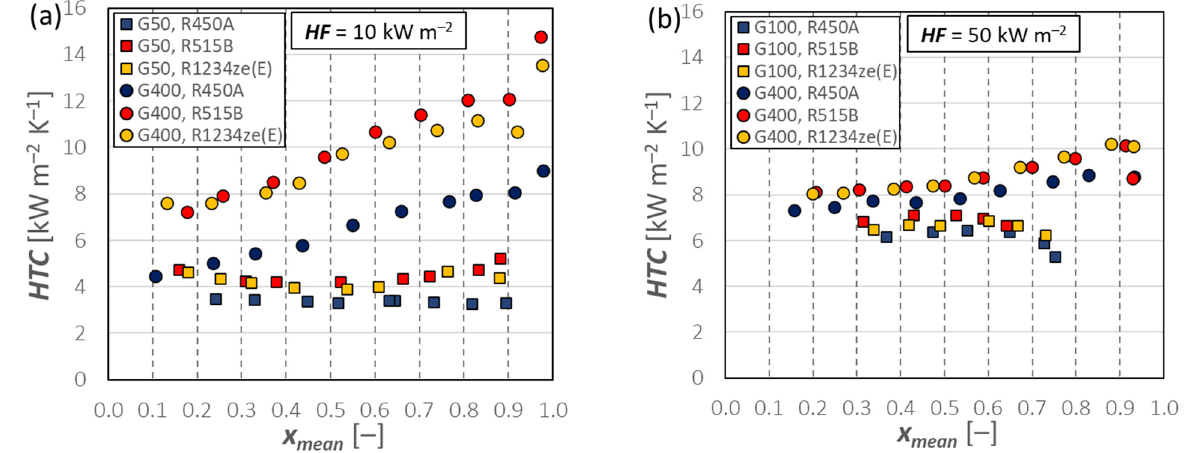
Figure 5. Heat transfer coefficient vs. mean vapor quality at t sat = 30 °C for R450A, R515B, and R1234ze (E) at HF = 10 kW m − 2 ( a ) and HF = 50 kW m − 2 ( b ). G50 = 50 kg m − 2 s − 1 , G100 = 100 kg m − 2 s − 1 , and G400 = 400 kg m − 2 s − 1 .